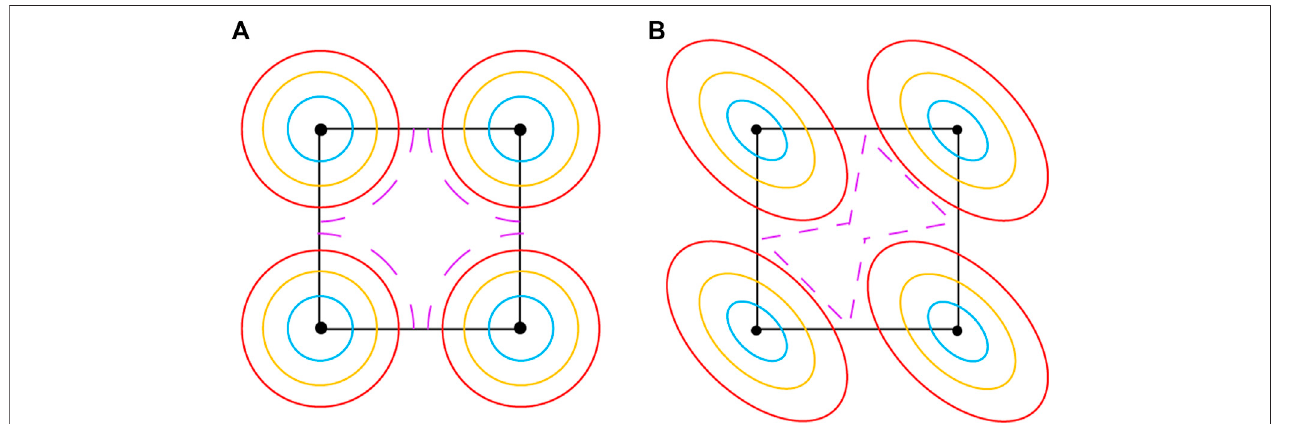
FIGURE 1 | Topological engineering of IFCs utilizing the degree of freedom of index ellipsoids at a nonzero k -point. While the centers of index ellipsoids are determined by the global connectivity of the metallic mesh, the shapes of index ellipsoids can be designed via the structural details of the mesh. (A) IFCs of the metamaterial with an isotropic index circle at the Brillouin zone corner. As the frequency increases, the four circles grow and shape into a cruciform. (B) IFCs of the MM with an anisotropic index ellipse at the Brillouin zone corner. As the frequency increases, the four ellipses grow and shape into a bowtie.